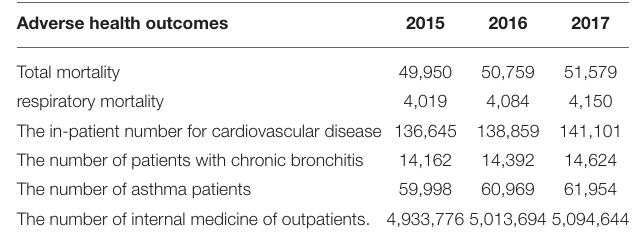
TABLE 4 | Exposure-response relationship coefficient and baseline incidence of relevant adverse health outcomes.